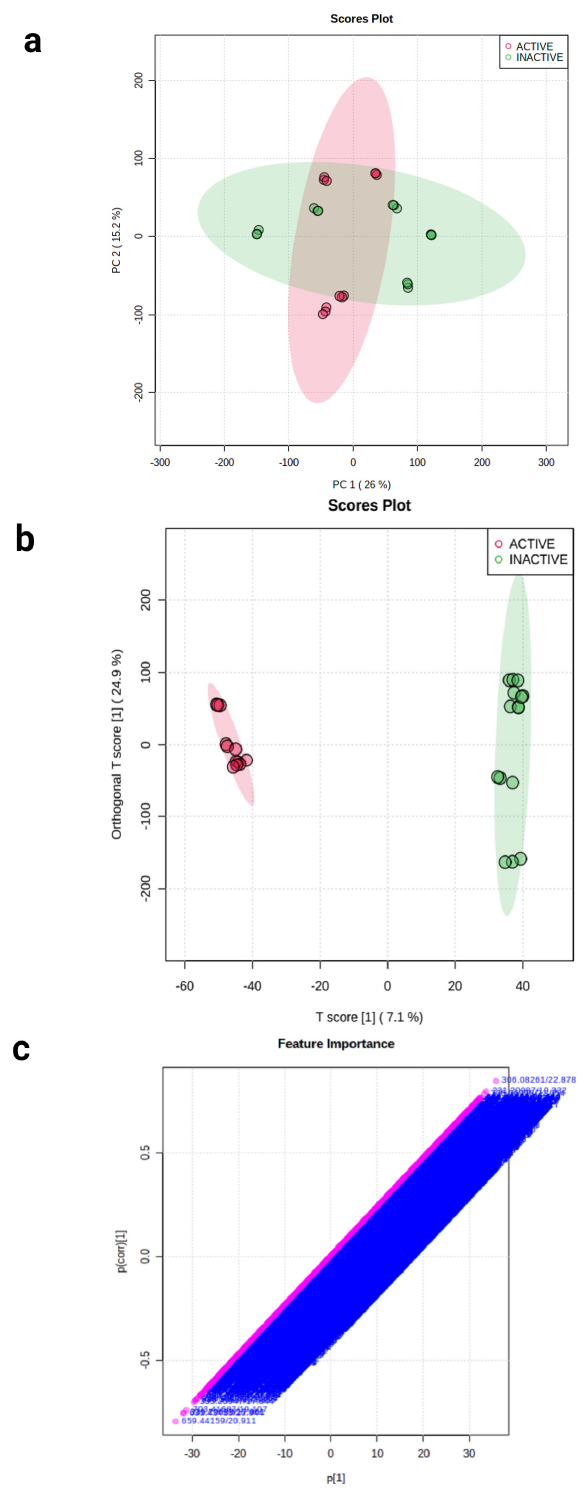
Figure 4. Comparative metabolomics of F15-17 cytotoxic active and inactive fractions. ( a ) PCA scores plot for F15-17 subfractions. ( b ) OPLS-DA scores plot of all of the metabolite features of F15-17 subfractions. ( c ) PLS-DA loadings S-plot for F15-17 subfractions showing the variable importance in a model, combining the covariance and the correlation (p(corr)) loading profile.